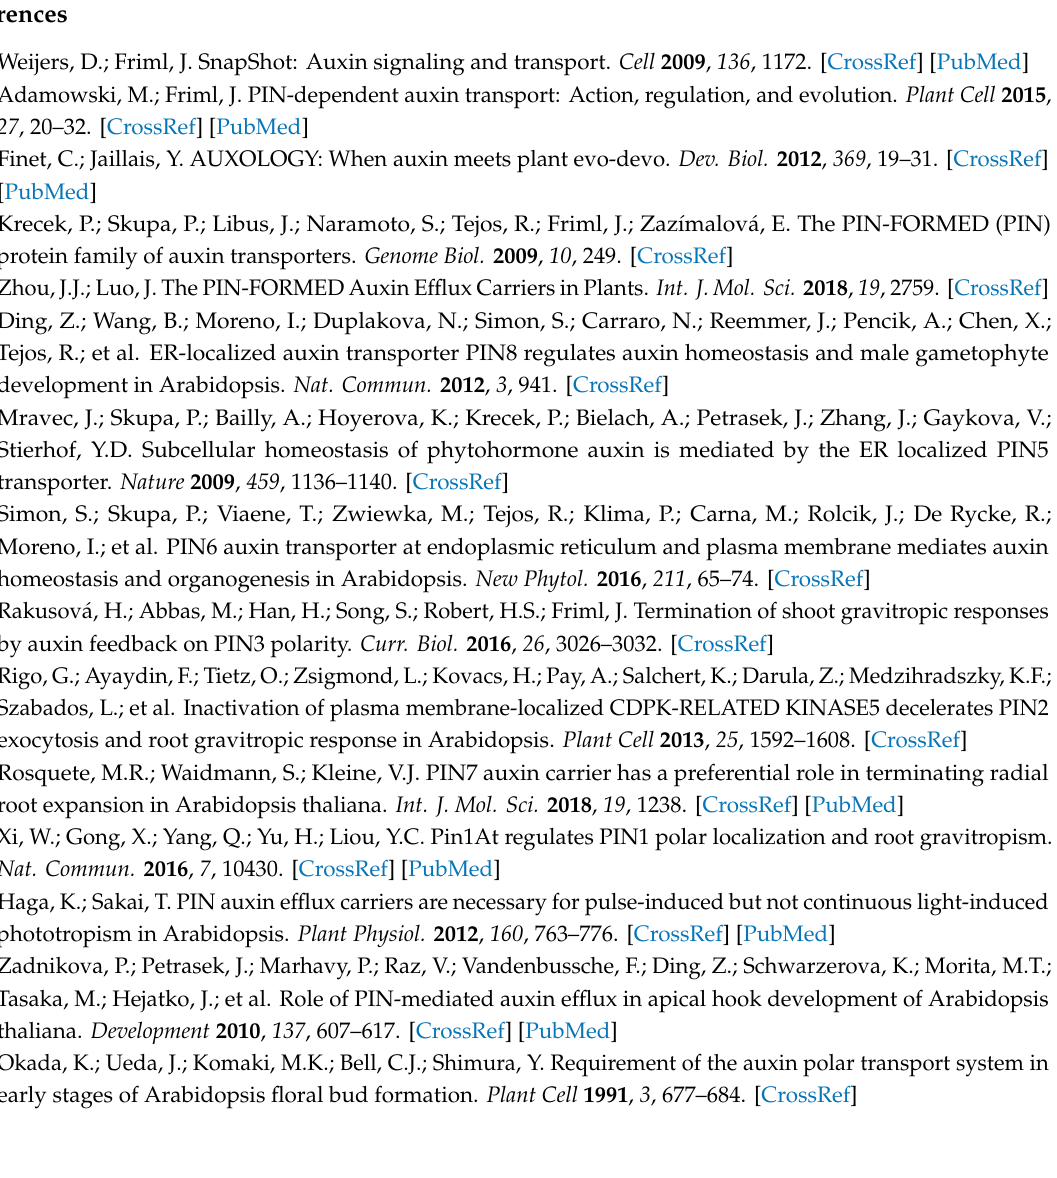
Figure S1: Transmembrane topology analysis of co ff ee PIN proteins. Figure S2: Conserved domains of co ff ee PIN proteins. Table S1: Gene ID, accession, sequence length, molecular weight, pI and CELLO localization of Arabidopsis PINs . Table S2: Sequence identity, nonsynonymous (Ka), synonymous nucleotide substitutions (Ks) and the ratio (Ka / Ks) of the co ff ee PIN gene pairs. Table S3: Cis -element prediction in upstream sequences of co ff ee PIN genes. Table S4: Ct values of CaPINs in di ff erent